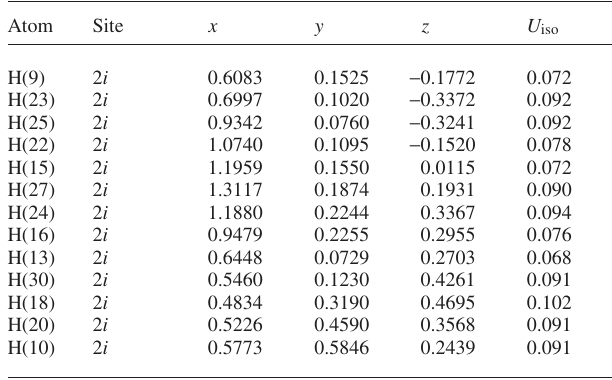
Table 2. Atomic coordinates and displacement parameters (in Å 2 )